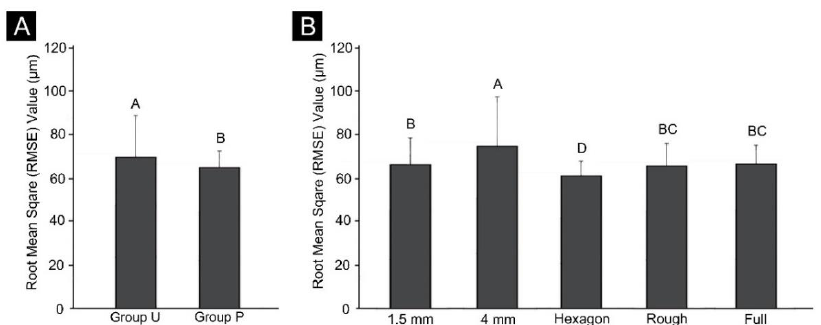
Figure 6. Results of the two-way ANOVA of precision ( A ) between Groups P and U and ( B ) between each internal-structure group. Uppercase letters indicate significant differences. Data are the mean and SD values.